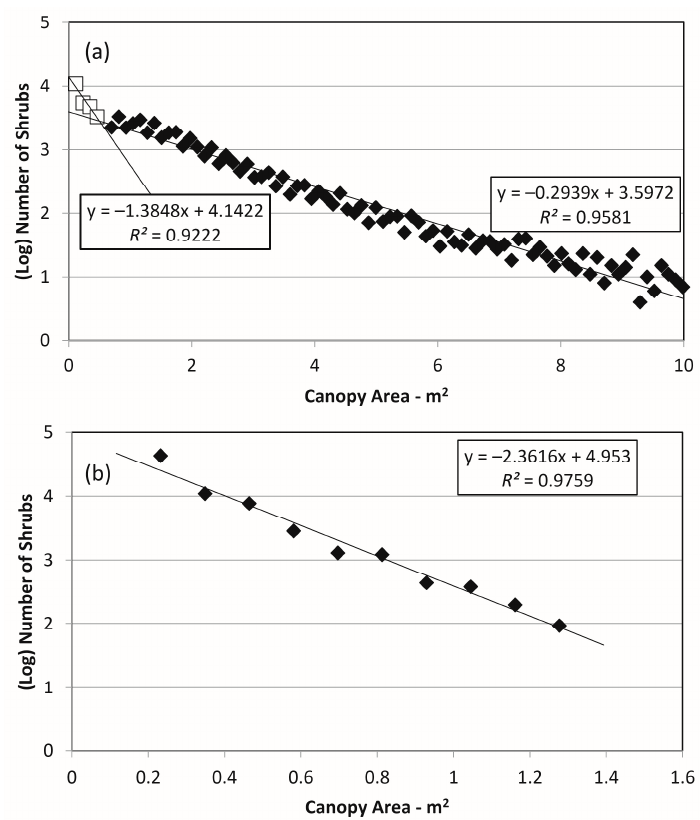
Figure 6. Log number of shrubs in different size classes, shown on X -axis, for ( a ) LATR and ( b ) AMDU. Solid lines are (log) linear-regression lines. Note differences in X -axis range. Individual bins are 0.1161 m 2 , but the X -axis scale is shown as a round number to facilitate viewing. Regression lines significant at p <